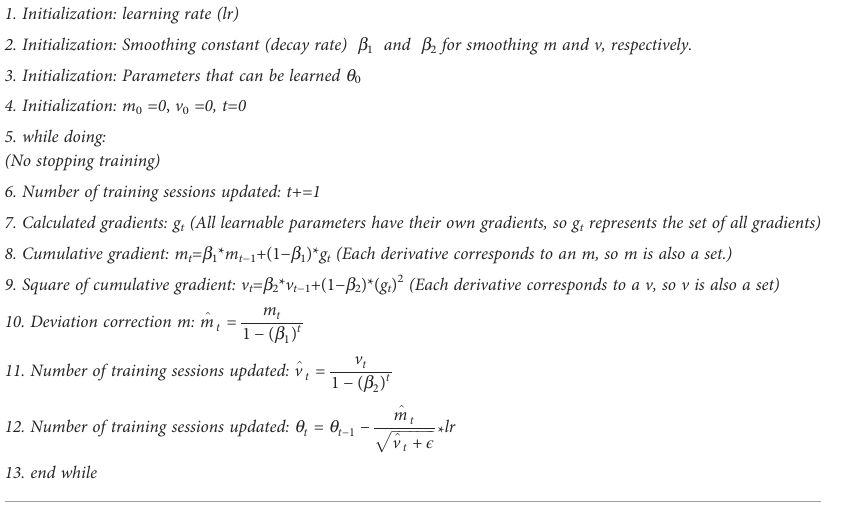
TABLE 2 Pseudo-code for the process of updating model parameters during network training.